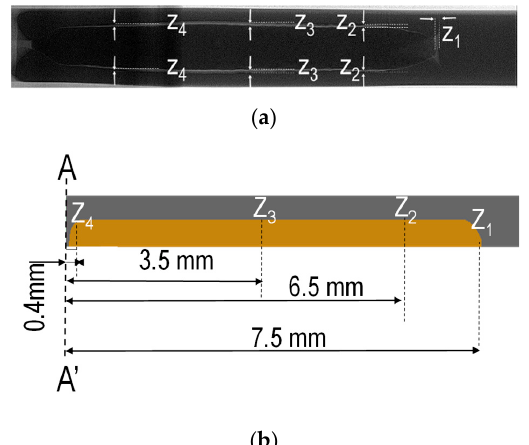
Figure 3. Measuring gaps: ( a ) typical cross-section after tomographic observation, ( b ) schematic representation of half of the ground electrode with exact locations of the gap measurements. Z 1 , Z 2 , Z 3 , and Z 4 are microscopic gaps between Copper and Inconel, measured respectively at 7.5, 6.5, 3.5, and 0.4 mm from AA’.